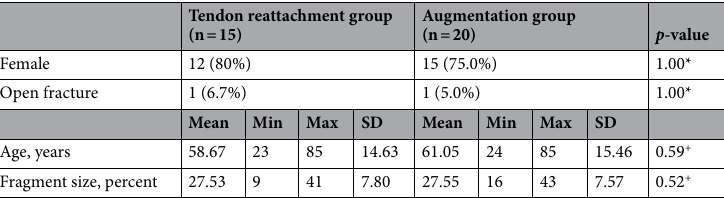
Table 1. Descriptive table of demographic variables. *Fisher’s exact test. + Mann–Whitney U test.